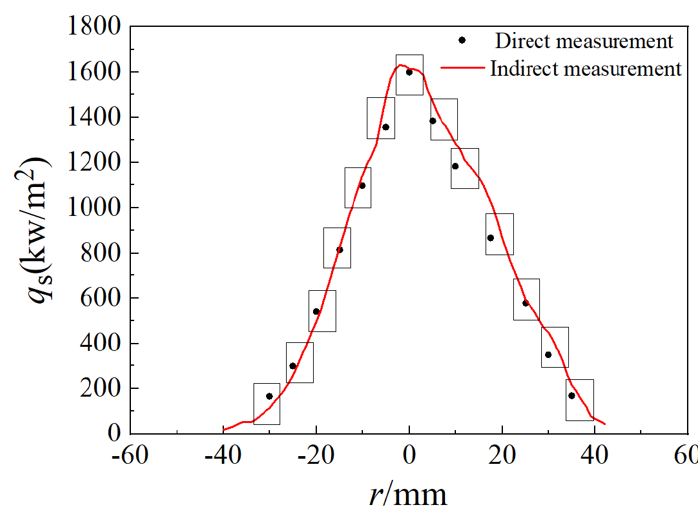
Figure 5. Composite measurement curves of the CSRF spot.